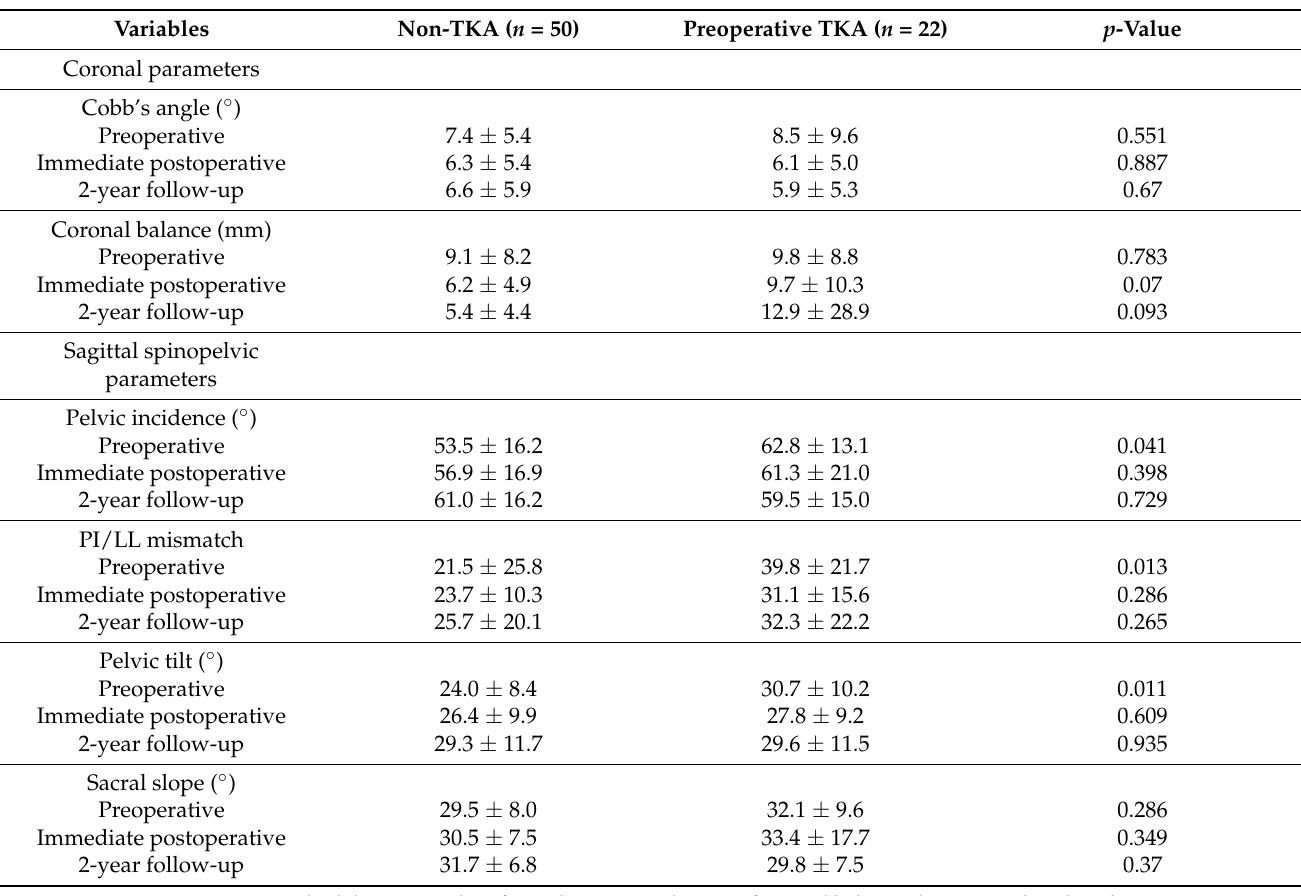
Table 3. Comparison of coronal and sagittal spinopelvic parameters between spinal fusion only and preoperative TKA with spinal fusion groups.